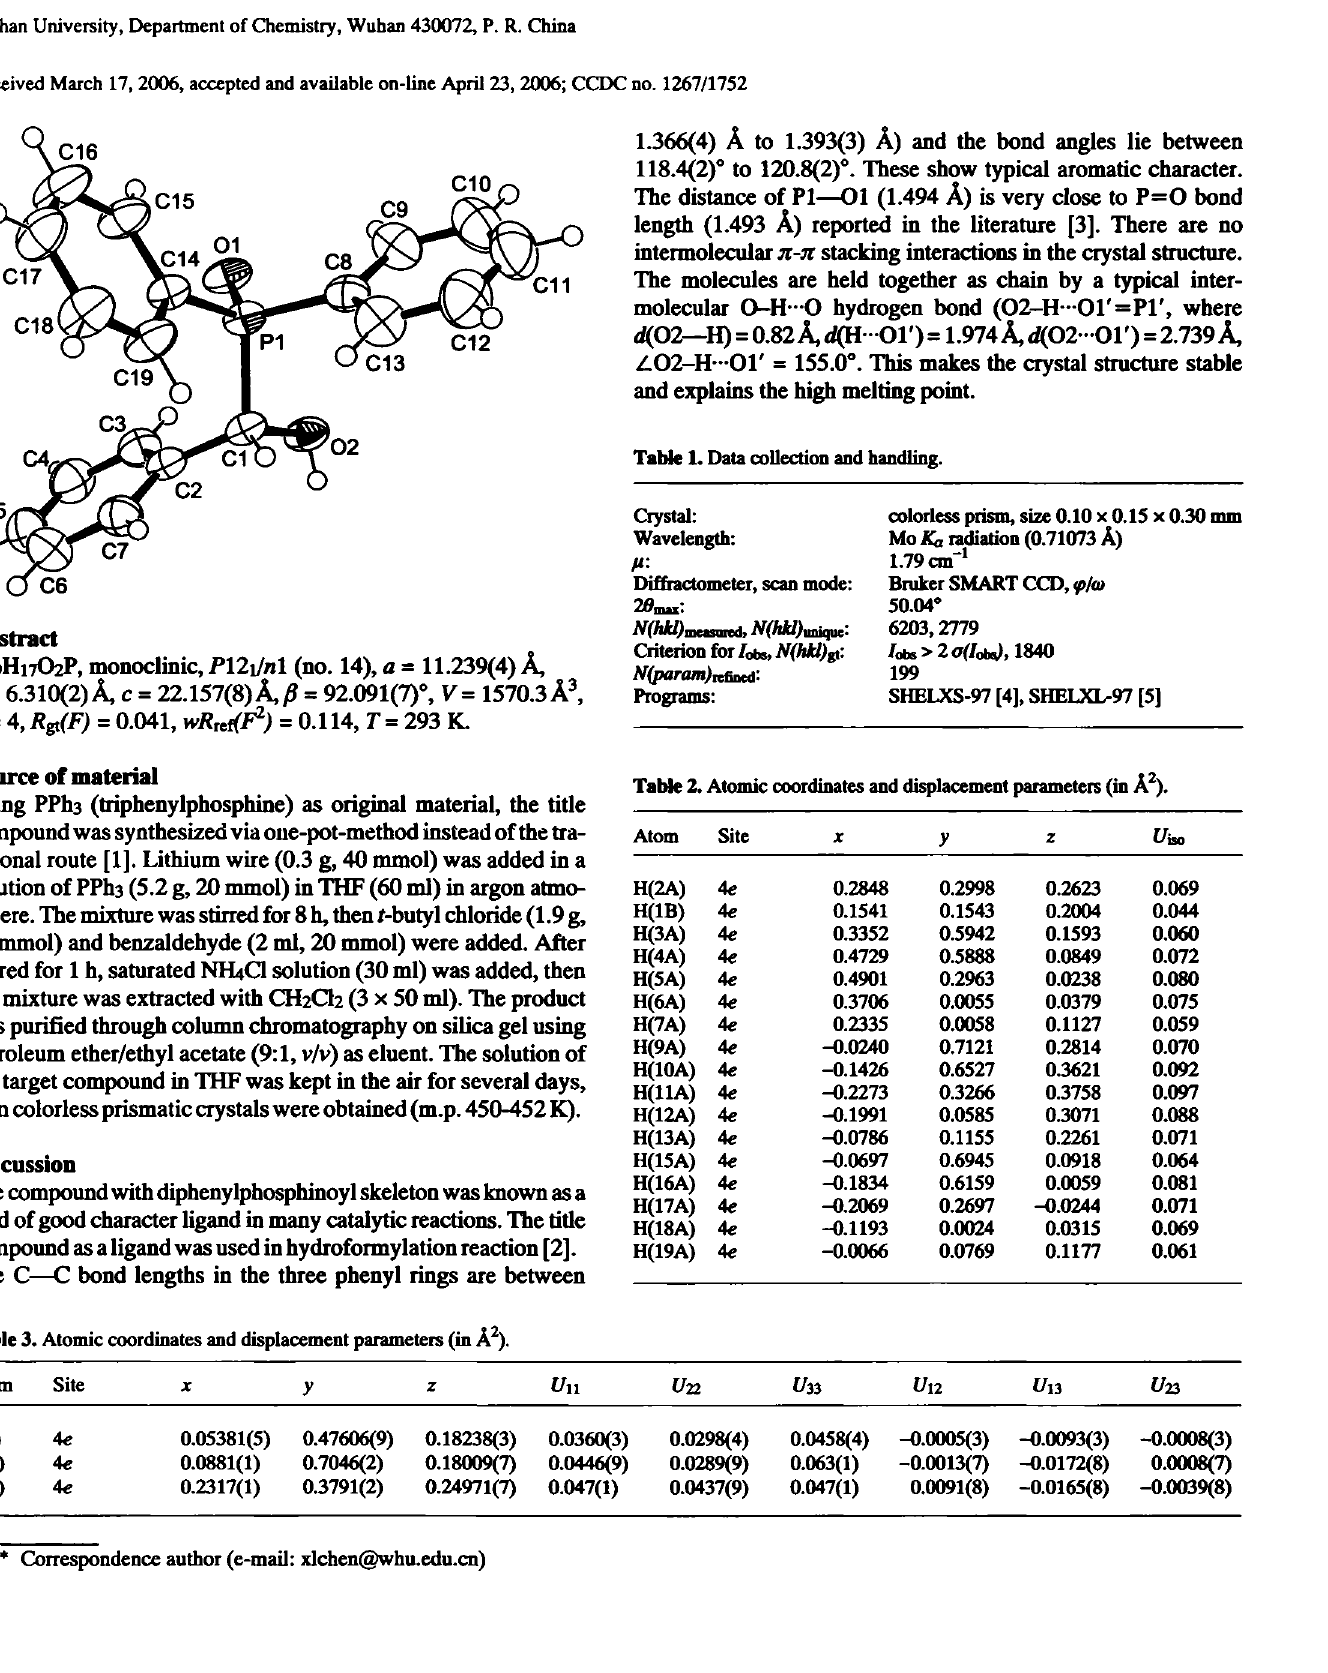
Table 3. Atomic coordinates and displacement parameters (in A 2